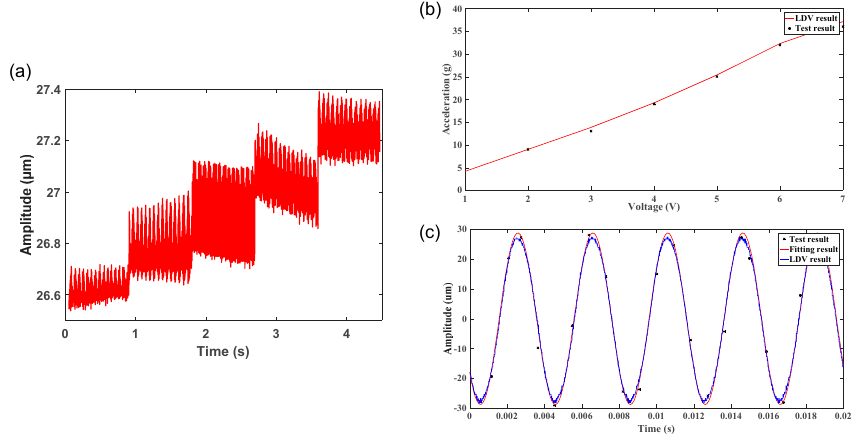
Figure 7. The measurement results comparison of LDVs versus OBDM detector. ( a ) Resolution measurement with steps of 150 nm. ( b ) Calculated acceleration output for increasing periodic excitations on the stage. ( c ) Measured amplitude output with time.